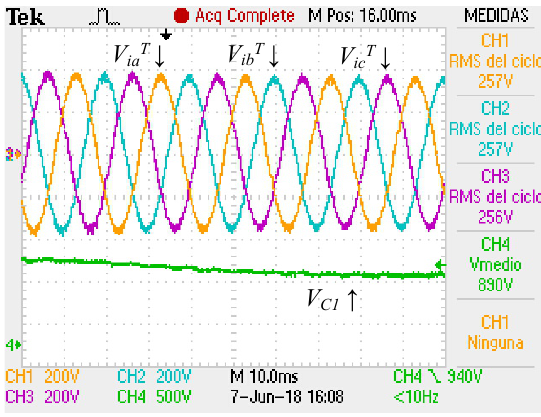
Figure 12. PCC i voltages and V C 1 .